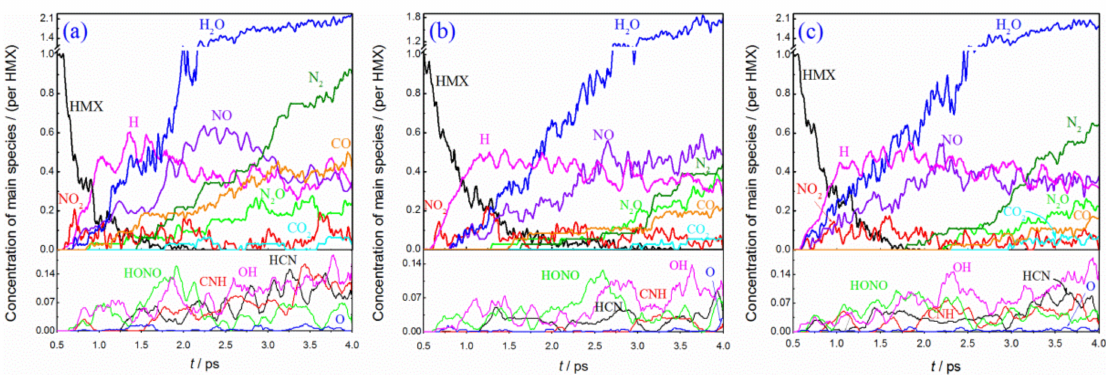
Figure 7. Main species involved in decomposition of HMX/HTPB composites: ( a ) HMX(100)/HTPB, ( b ) HMX(010)/HTPB, ( c ) HMX(001)/HTPB.